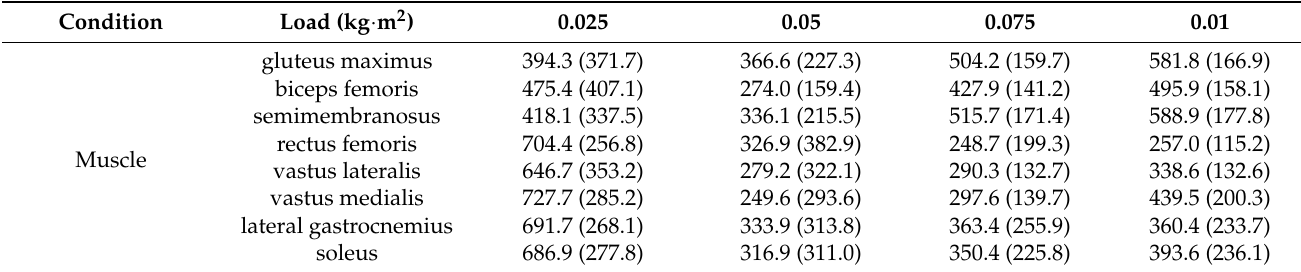
Table 2. Average activation times for each muscle and loading condition.